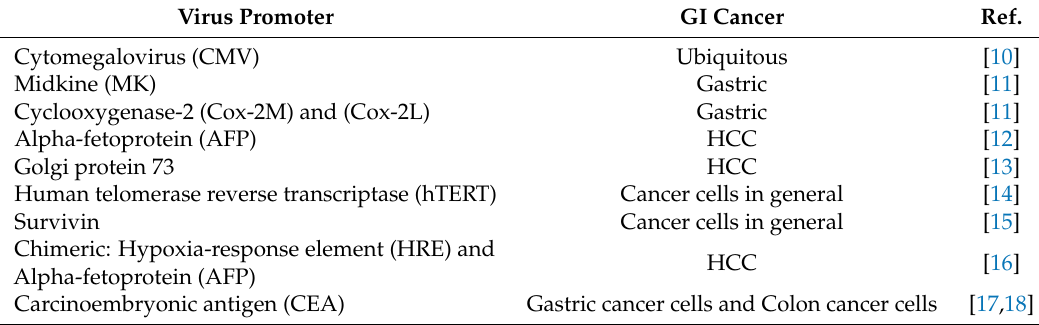
Table 2. Adenoviral platform and incorporated promoters for gastrointestinal